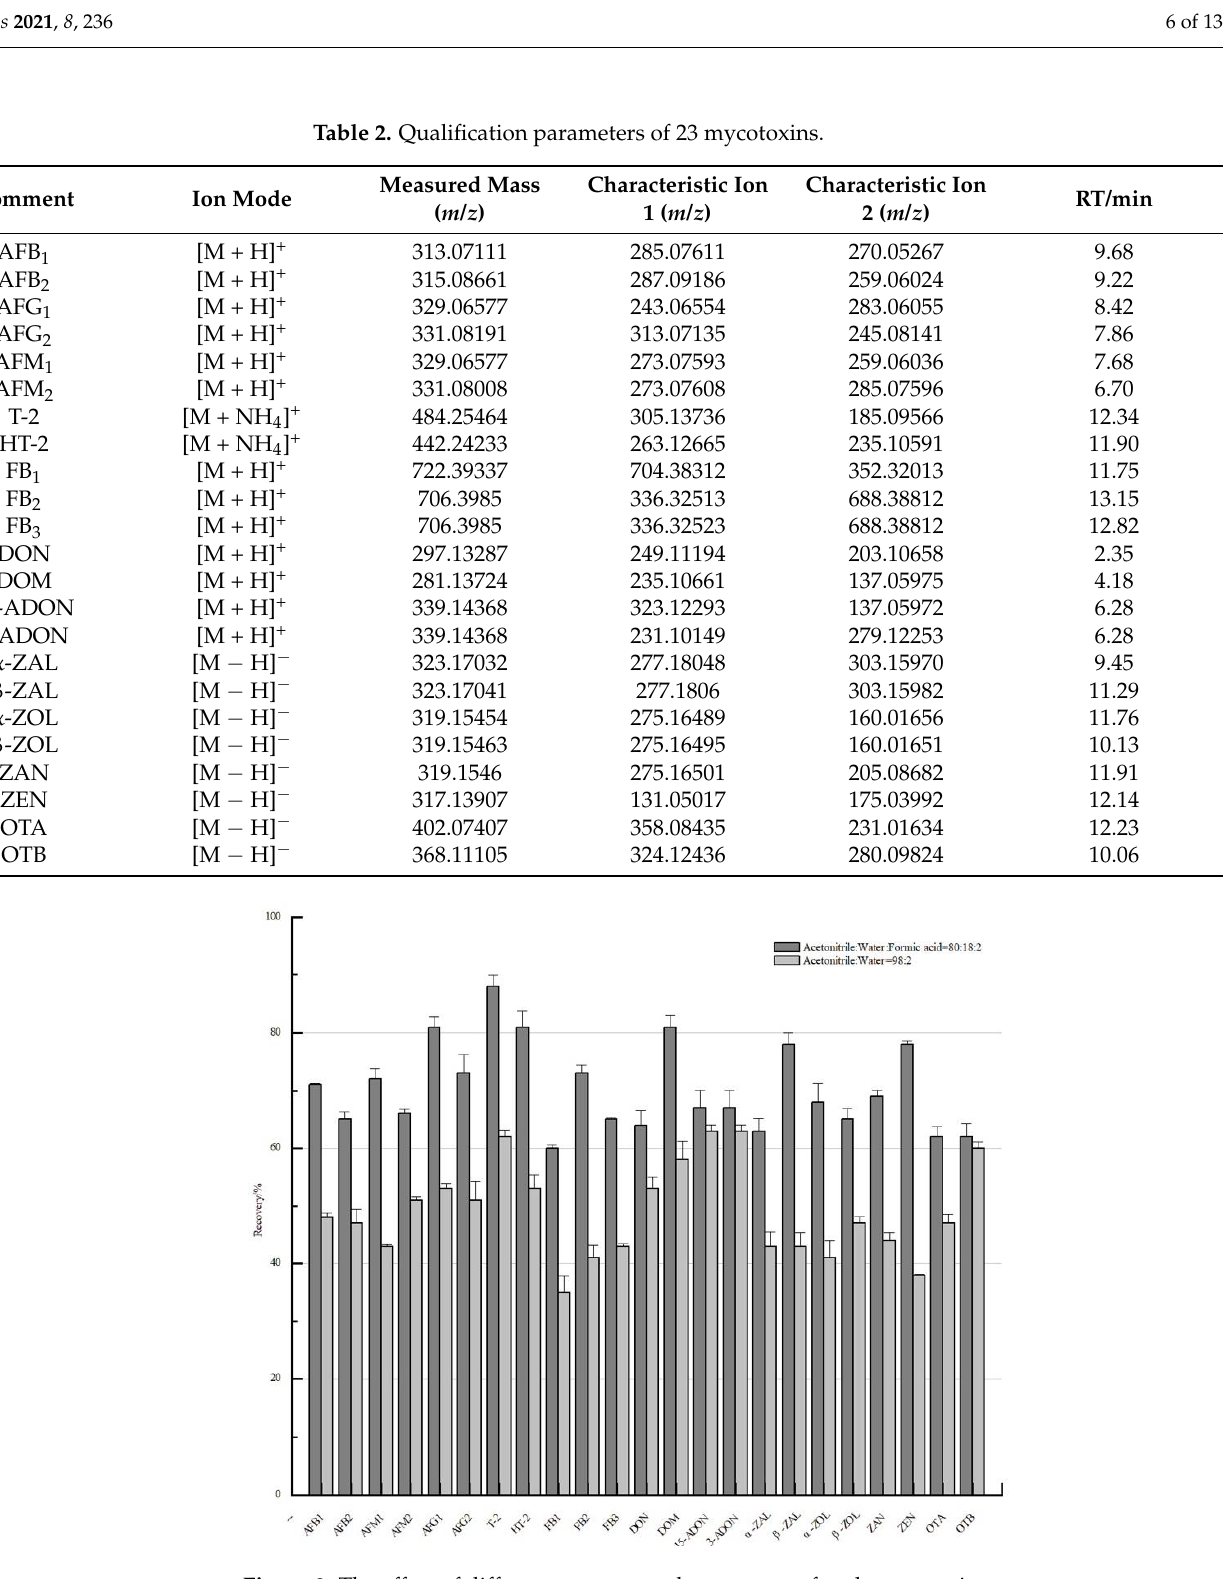
Figure 2. The effect of different extracts on the recovery of each